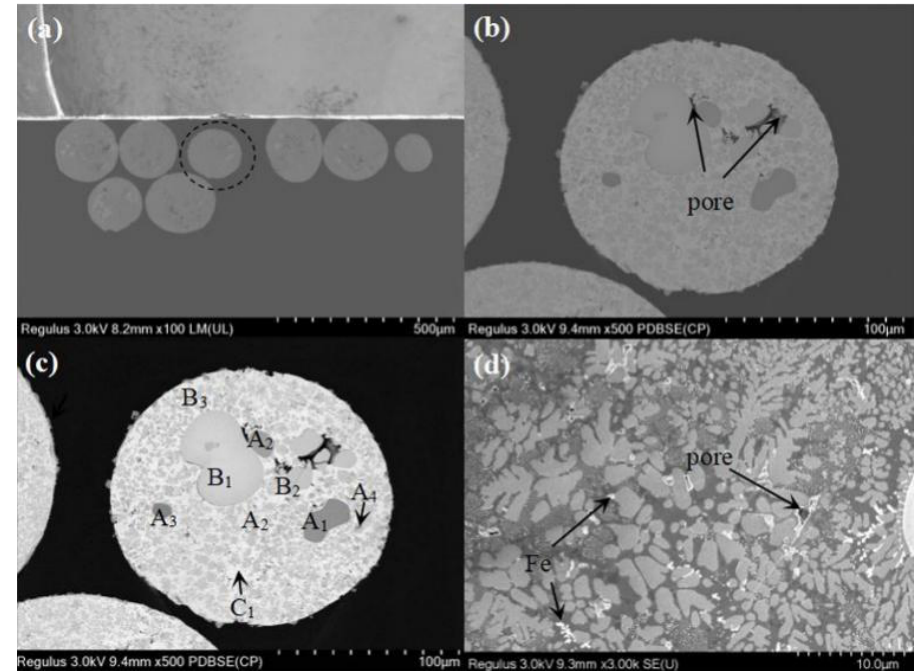
Figure 3. Cross-sectional morphology of the sample (( a ) Low magnification FESEM micrograph; ( b ) Enlarged image of ( a ); ( c ) Image J images of ( b ); ( d ) High magnification FESEM micrograph).